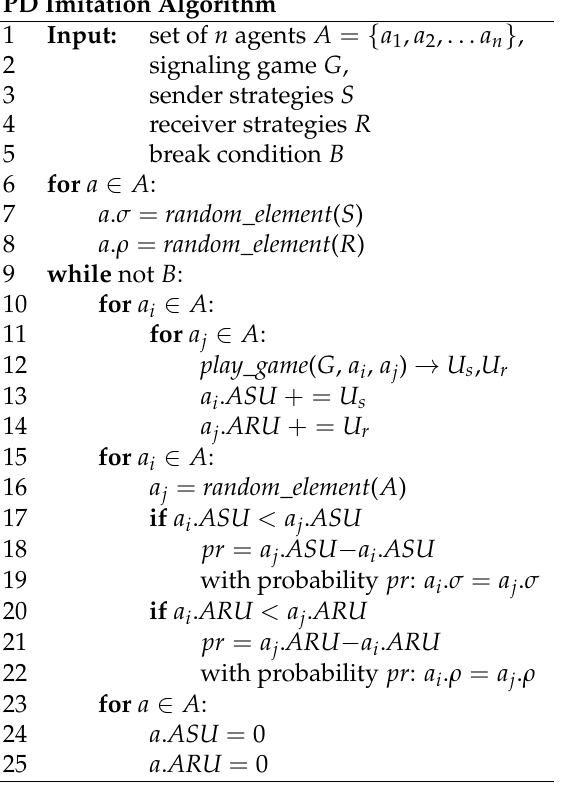
Figure A1. Pseudo Python code of the ‘pairwise difference’ imitation